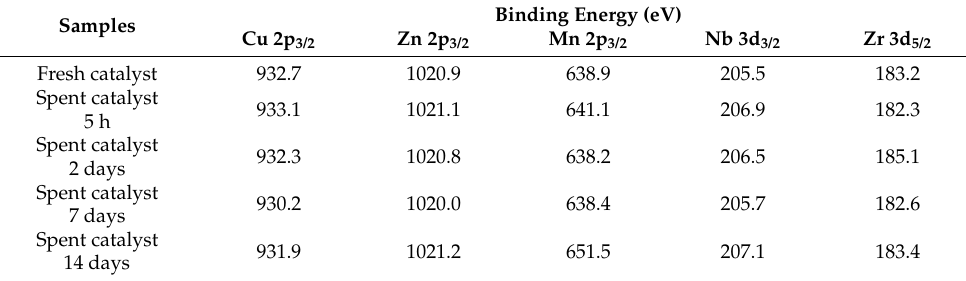
Table 7. Binding energy for each element.